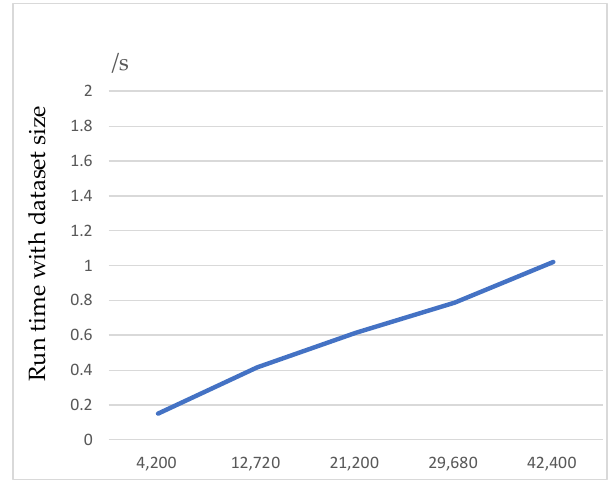
Figure 9. Run time with dataset size.